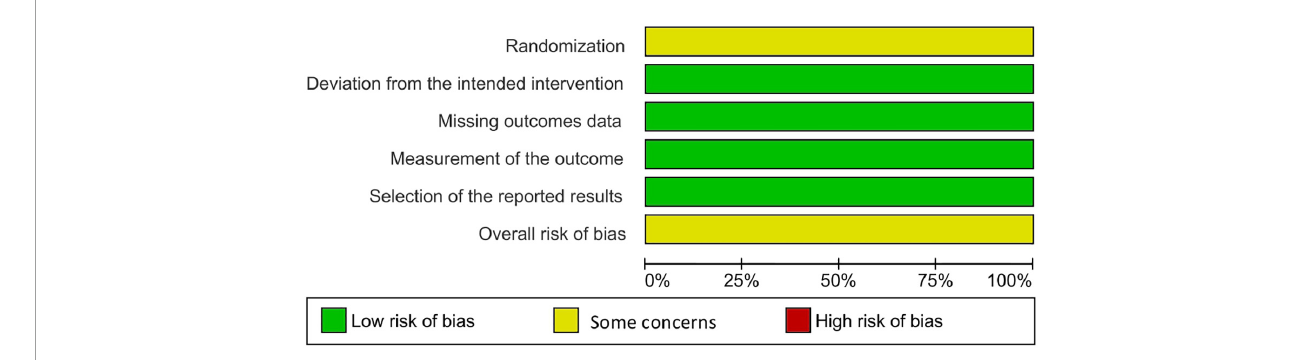
FIGURE2 Risk of bias graph.